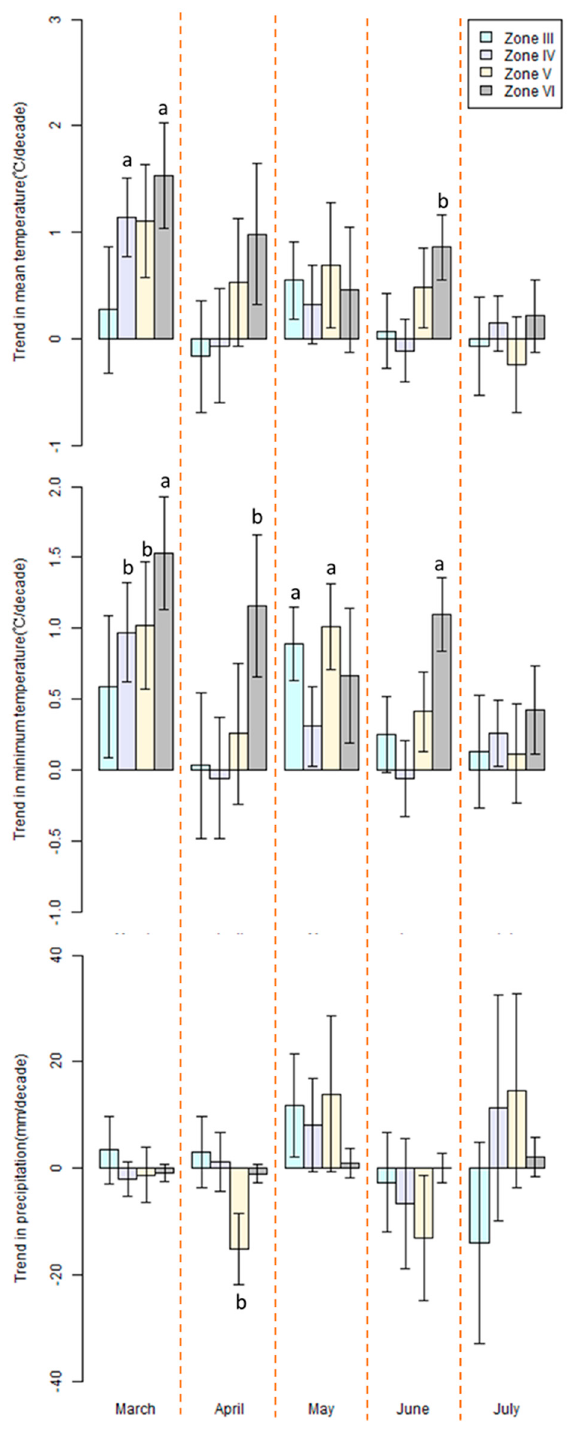
Figure 4. Trends in T, T min and precipitation during February to June of summary maize from 1992 to 2010 in each maize production zone. The error bar represents the standard error of the estimates. The trends with a mark ‘a’ are significant at 0.01 level, and with a mark ‘b’ are significant at 0.05 level. In addition, the trends in T, T min , and precipitation for the di ff erent zones in March, April, May, and June are not the same between Figures 3 and 4. That’s because stations are di ff erent for spring and summer maize, although some regions such as Zones IV, V, and VI have a spring maize station and a summer maize station. One station only has one type